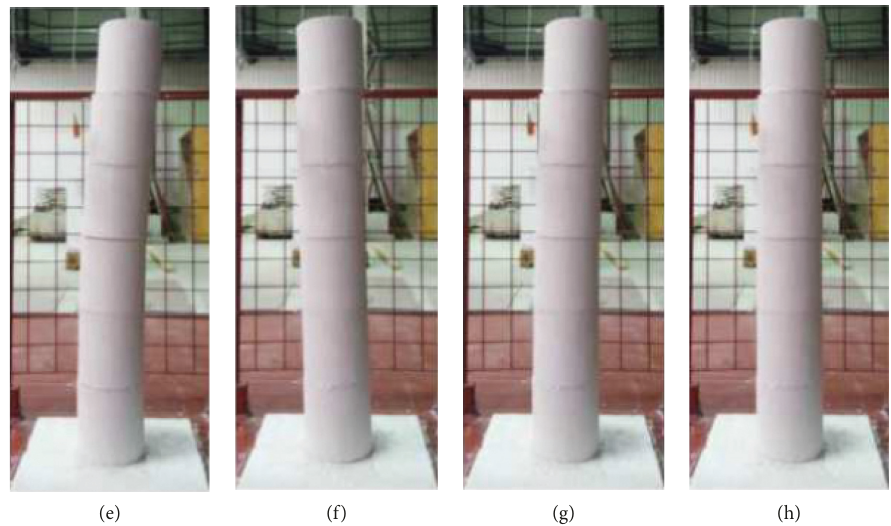
Figure 13: Appearance of the column S6 for the Ston accelerogram at a